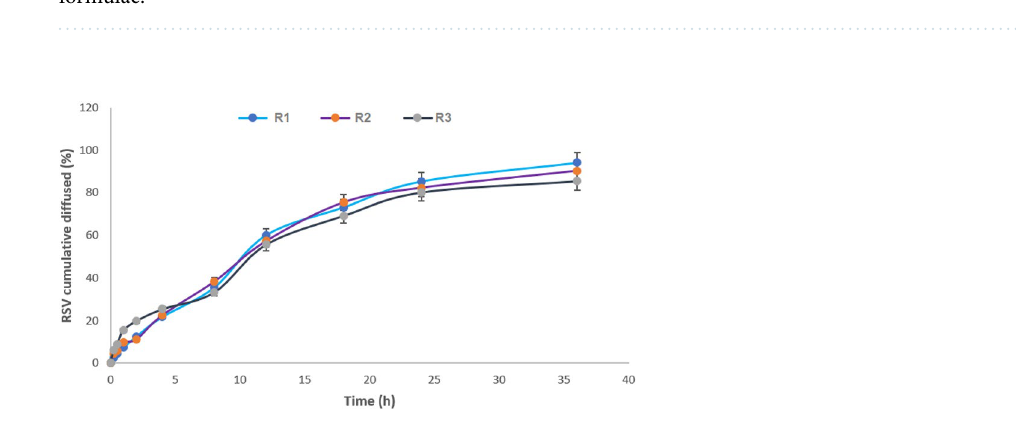
Figure 1. In vitro diffusion profile of ZN-RSV NPs